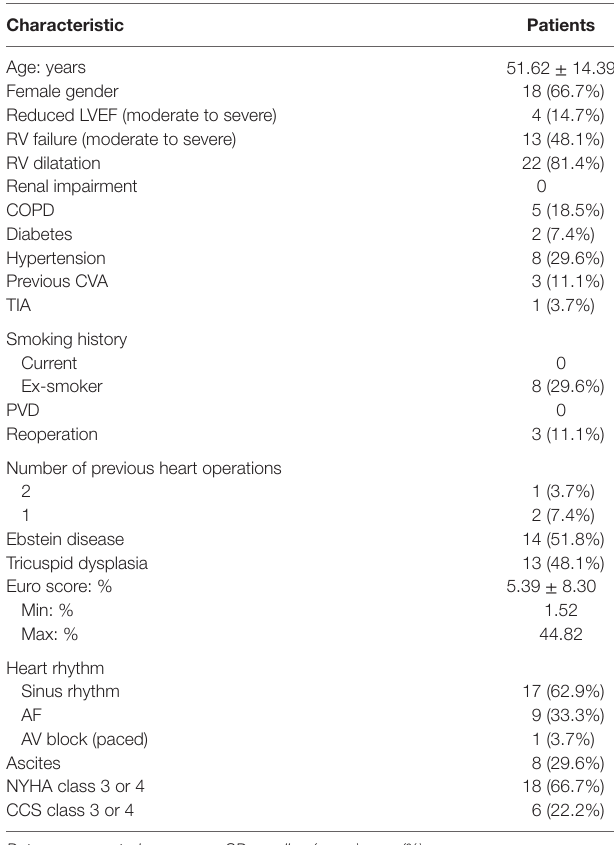
TaBle 1 | Preoperative characteristics of patients with isolated tricuspid repair ( n =